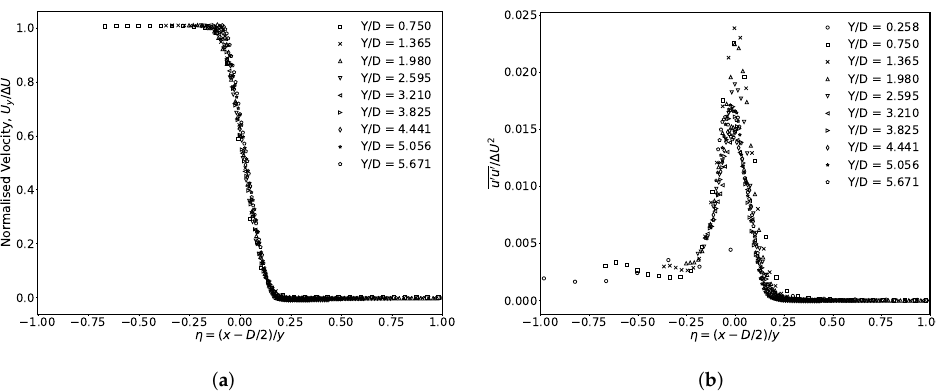
Figure 5. Self-similarity is detected in the shear layer development as the velocity profiles and Reynolds stress profiles, u (cid:48) u (cid:48) , are seen to collapse on a single line after appropriate scaling. The turbulent Reynolds stress is observed to require longer streamwise development than velocity to reach this state. ( a ) Streamwise velocity. ( b ) Cross-stream Reynolds stress, u (cid:48) u (cid:48) . Other turbulent properties are also expected to exhibit self-similarity. Profiles of the cross flow Reynolds stress component u (cid:48) u (cid:48) are also plotted in Figure 5b, where it is